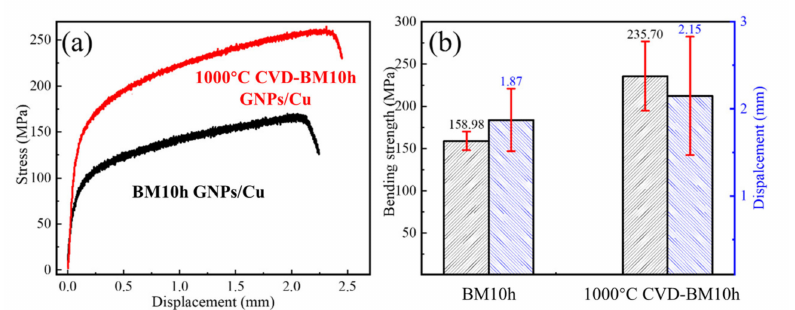
Figure 13. Bending performance of composites made by BM10h and 1000 ◦ C CVD-BM10h. ( a ) Deflection-stress curve, ( b ) Flexural strength and fracture deflection of